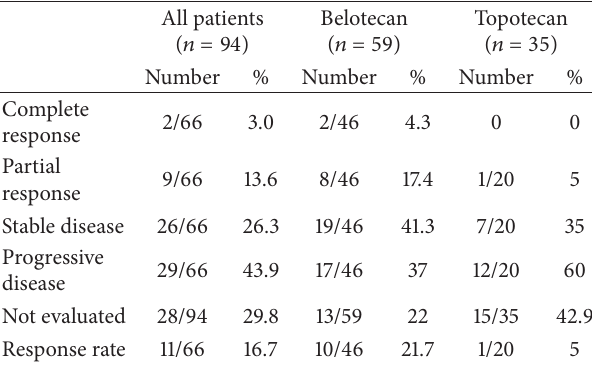
Table 2: Chemotherapy